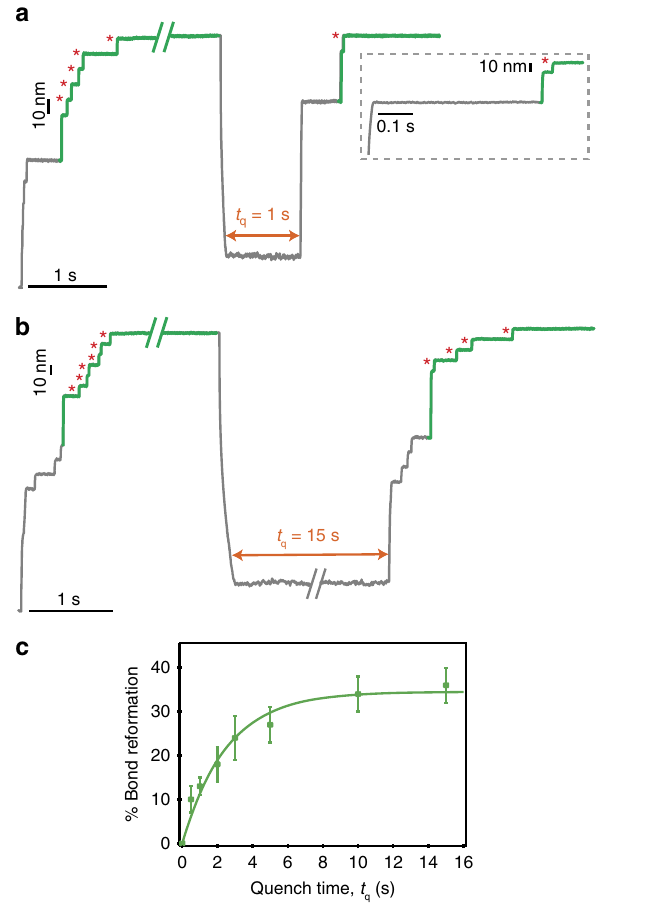
Figure 2 | Kinetics of disulfide bond reformation. ( a , b ) The percentage of disulfide reformation, fingerprinted by the presence of B 10nm steps (red asterisks), increases with t q . a illustrates a particular trajectory showing that the reformation of the disulfide bond (marked by the 10nm step) occurred in the absence of protein refolding, since the 10nm step, corresponding to the rupture of the disulfide bond, is not preceded by a 15nm step, hallmark of protein refolding. This suggests that, in this particular trajectory, we interrupted the oxidative folding process at an instant whereby the reformation of the disulfide bond had occurred but the protein did not have yet time to fold. ( c ) The percentage of disulfide bond reformation increases exponentially with t q with an associated rate constant of k ref ¼ 0.45s (cid:2) 1 (solid green line, w 2 red ¼ 0.513).